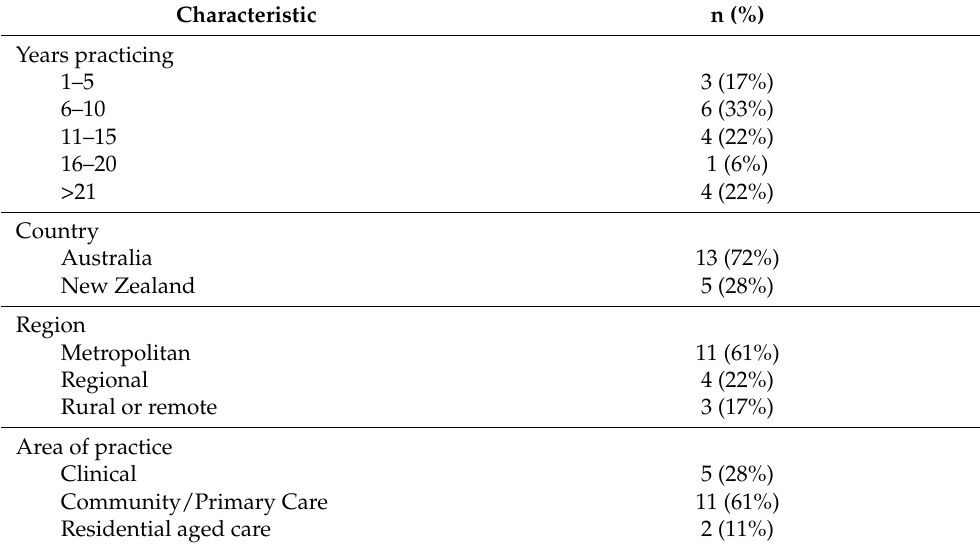
Table 2. Demographic information of participants (n =